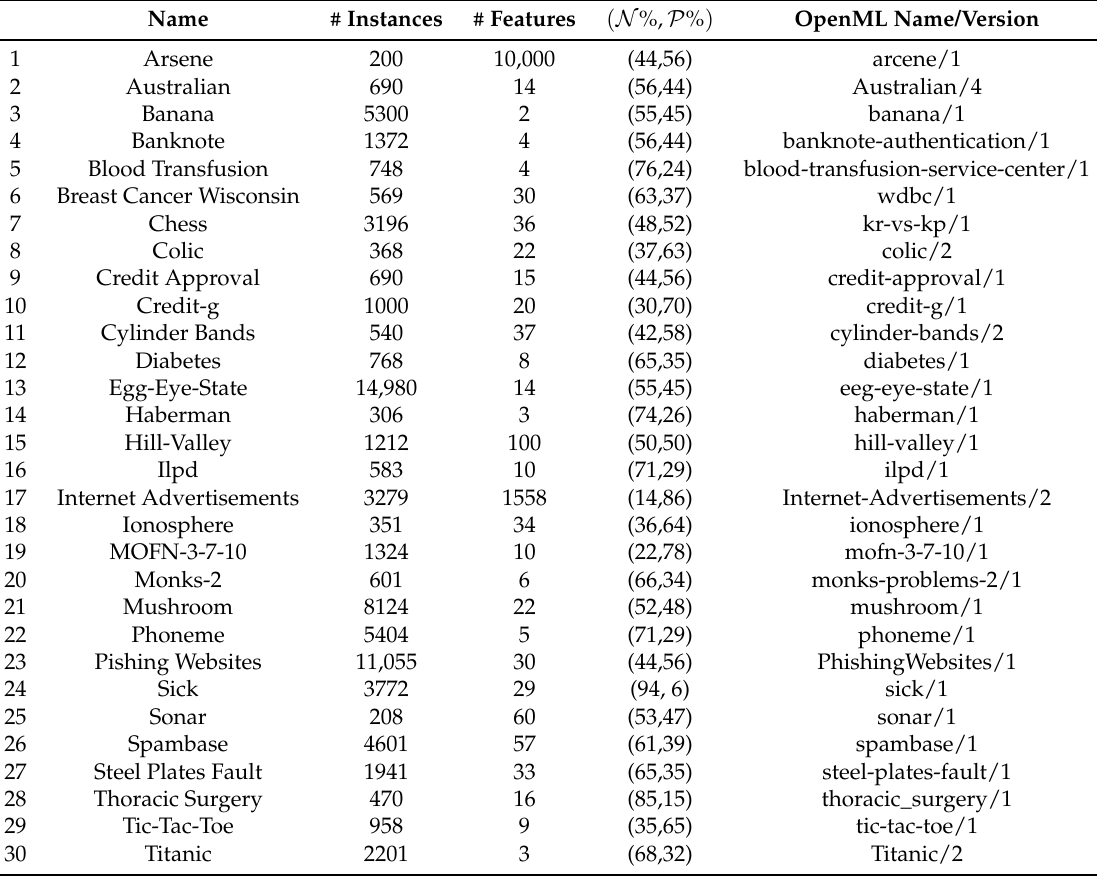
Table 3. Informations on the considered datasets.